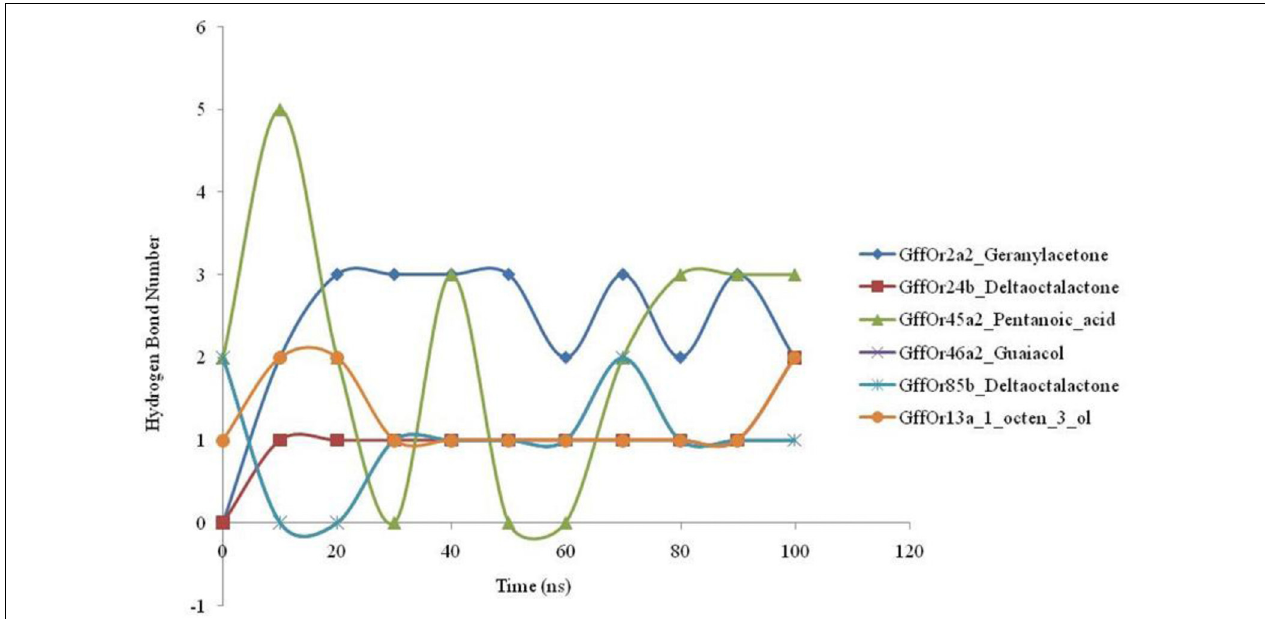
FIGURE 4 | Time-lapse curves highlighting the changes observed in the number of hydrogen bonds between the receptors and the studied ligands during the course of 100-ns MD simulations.